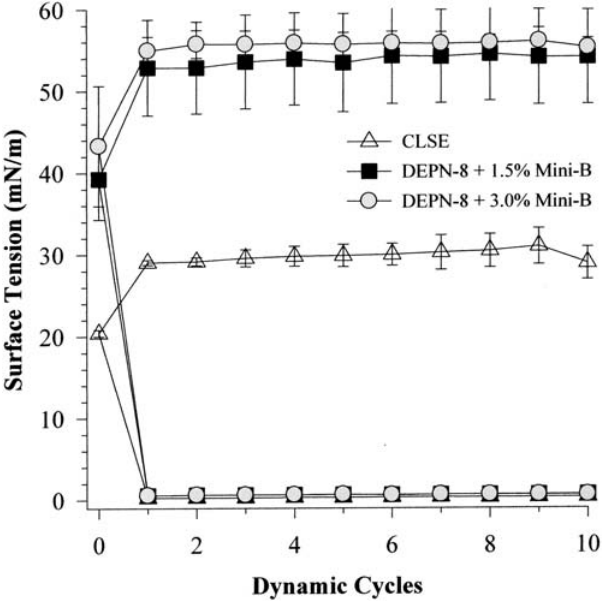
Figure 6. Dynamic surface activity of DEPN-8 + 1.5% or 3% Mini-B compared to CLSE on the captive bubble surfactometer. Minimum and maximum surface tensions are shown for DEPN-8 + 1.5% or 3% by weight Mini-B and CLSE on a captive bubble surfactometer during 10 cycles of rapid compression (20 cycles/min) following slow compression as in Figure 5. Surface tension values are Mean 6 SEM for at least three separate experiments. See text for details.